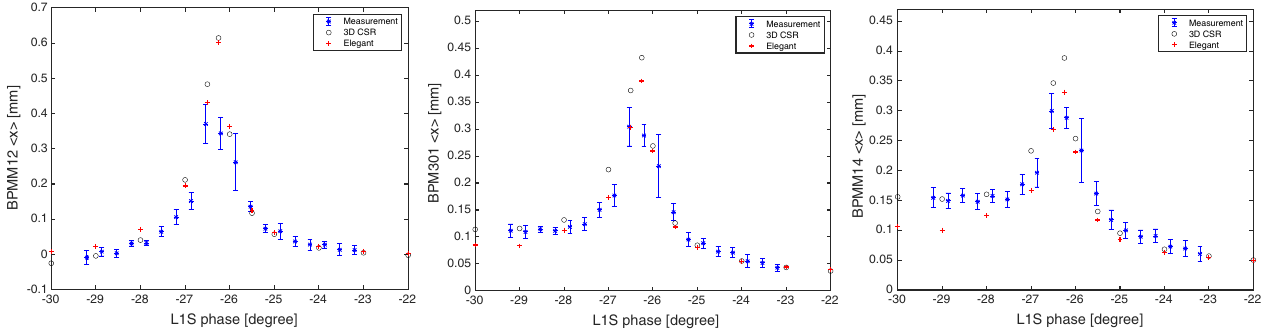
FIG. 11. A comparison of the measurements and simulations of the horizontal beam position for the first bunch compressor in the LCLS.